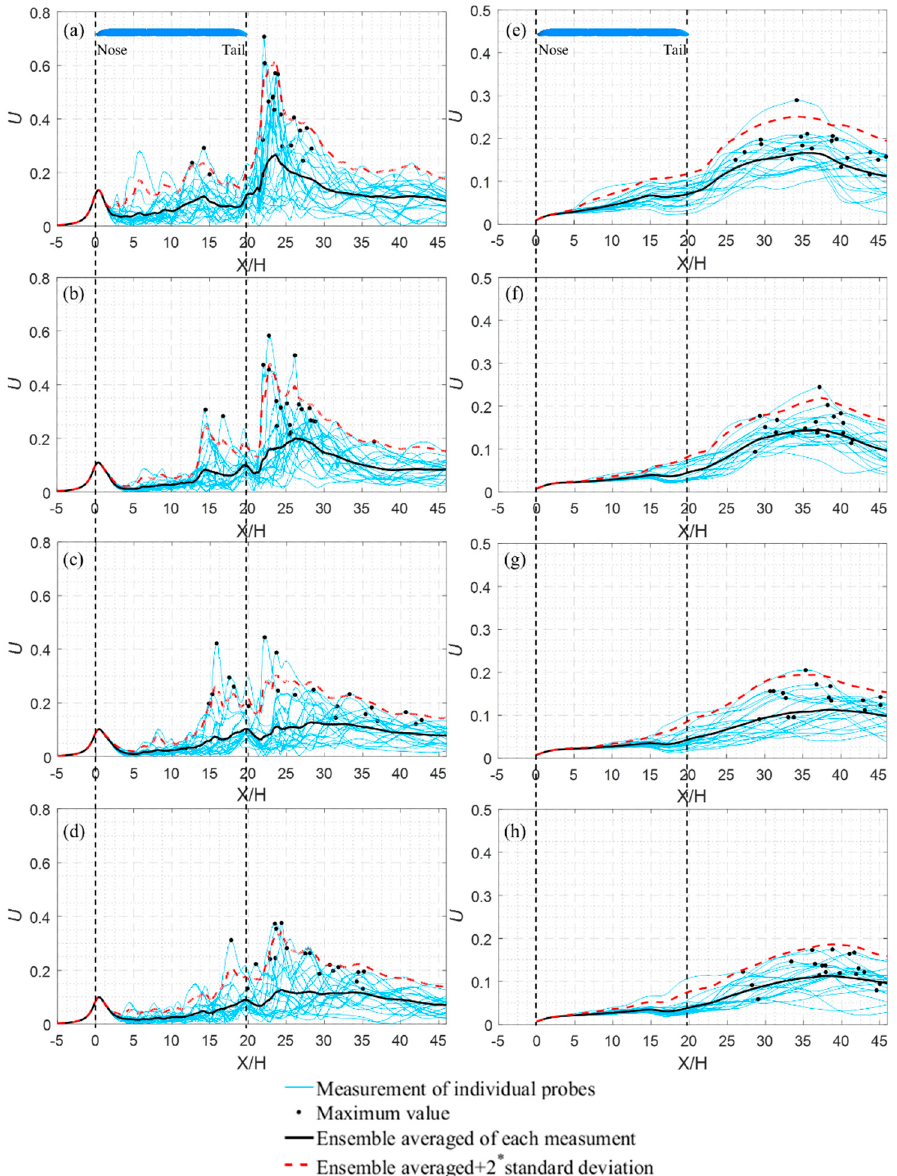
Figure 15. Instantaneous horizontal velocity for 20 individual runs at trackside position. Blue solid line: ensemble average of individual probes. Black solid line: ensemble average. Red dashed line: ensemble average + 2* standard deviation. Black dashed line: nose and tail. (From top to bottom: 4, 7, 9, and 12 m. Left: without 1 s moving average (MA); right: with 1 s MA). Table 3. Peak values of gust measurement without and with 1 s MA.